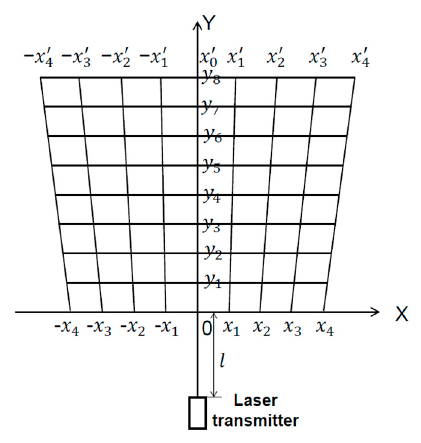
Figure 6. The actual laser grid image.